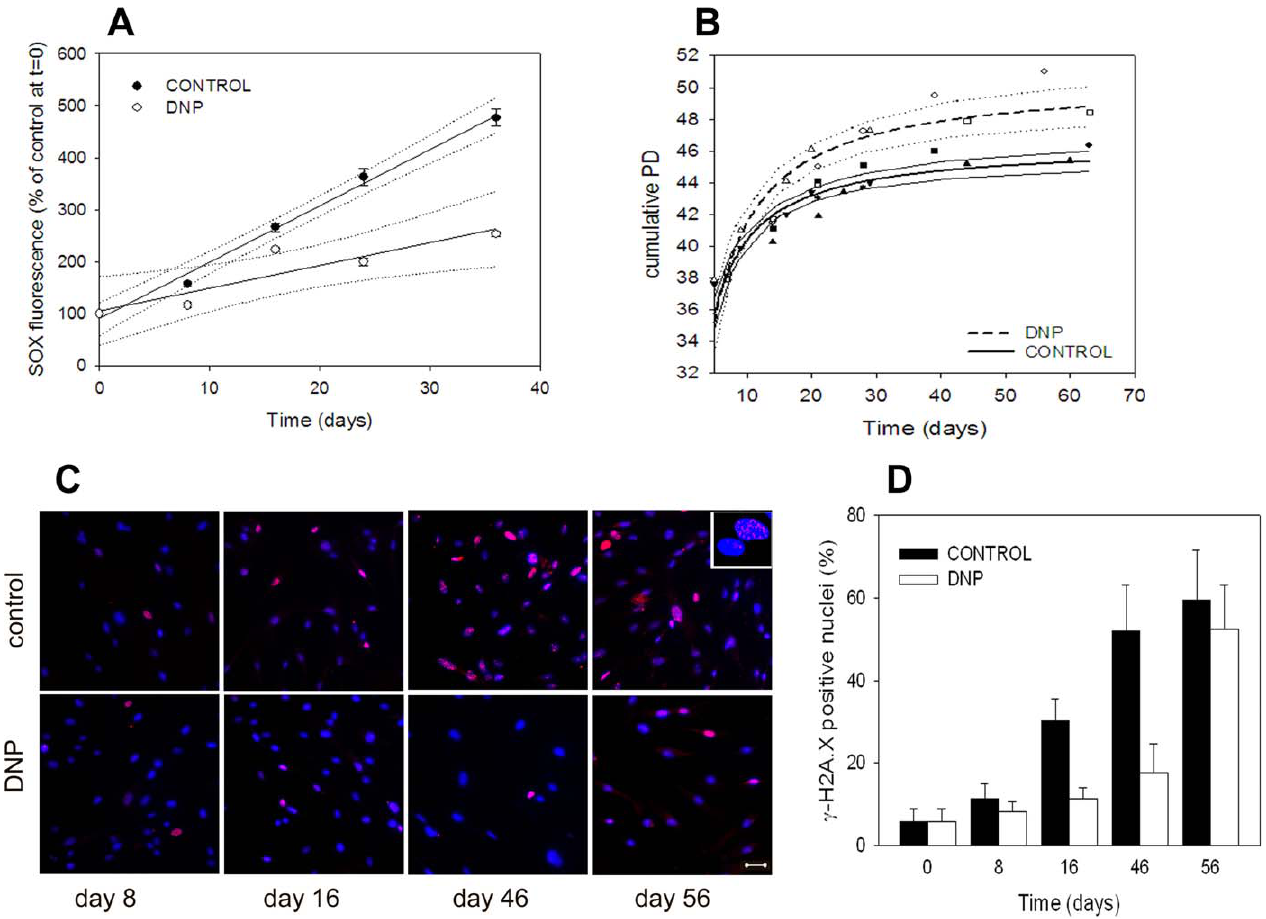
Figure 3. Mild Uncoupling by DNP Prolongs Replicative Lifespan of Human Fibroblasts MRC5 fibroblasts were treated with 250 l M DNP from PD 35 till senescence. (A) MitoSOX fluorescence. Data are mean þ D m, n ¼ 2. Fluorescence intensity at t ¼ 0 was set to 100%. Solid line: linear regression, dotted lines: 95% confidence intervals. (B) Replicative lifespan. Data are from three (DNP) respective four (control) independent experiments. Hyperbolic best fits and 95% confidence intervals are shown. (C) c -H2A.X staining. The bar denotes 20 l m. Insert: higher magnification showing focal staining. (D) Frequency of c -H2A.X-positive fibroblasts. Data are mean 6 s.d., n ¼ 3. Differences are significant ( p , 0.05) between day 8 and